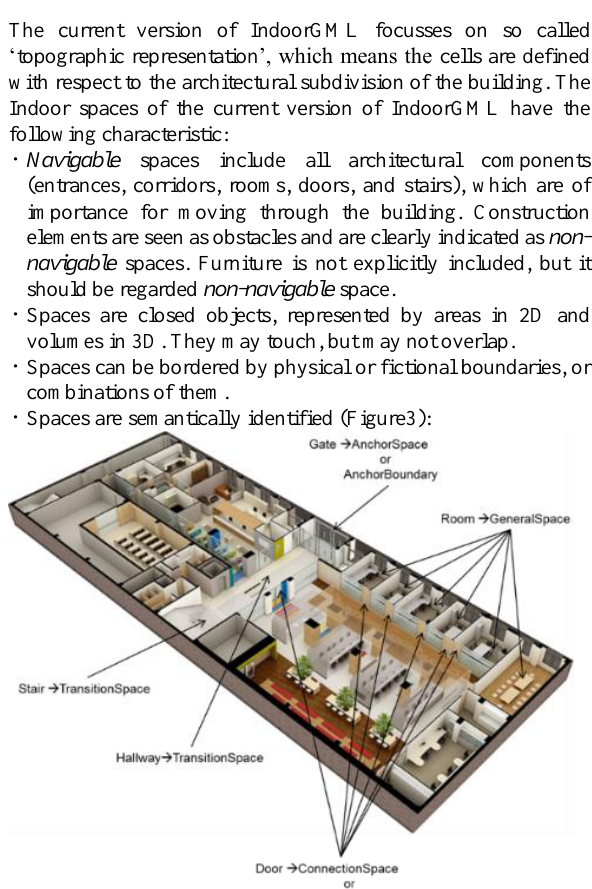
Figure 2: Union of topographic spaces to represent dangerous areas